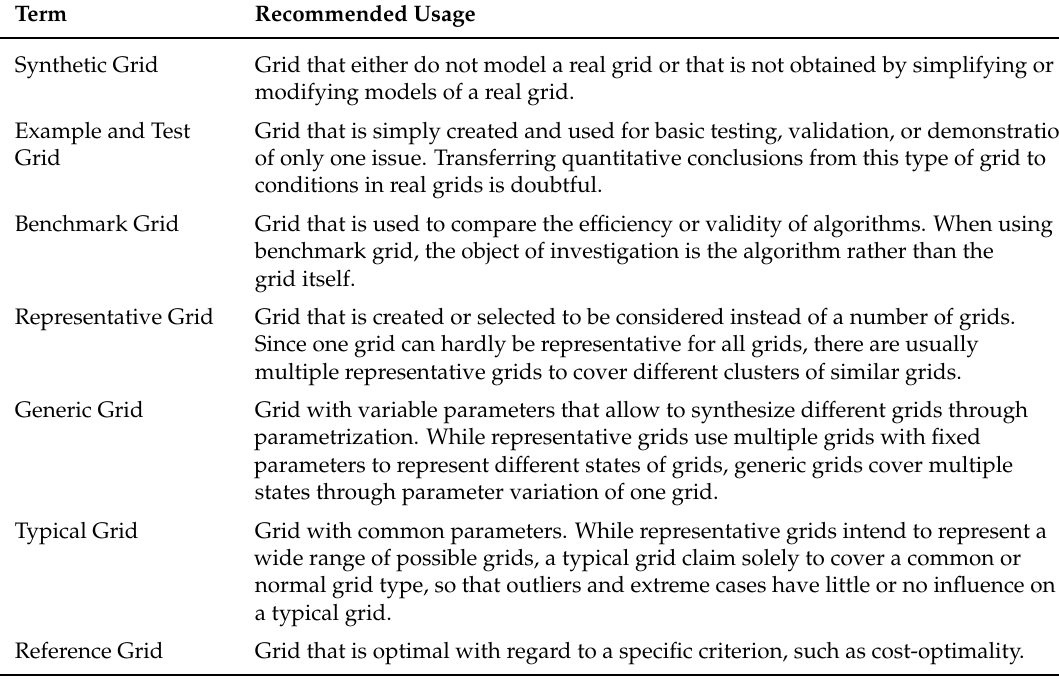
Table 3. Recommended terminology of common used grid